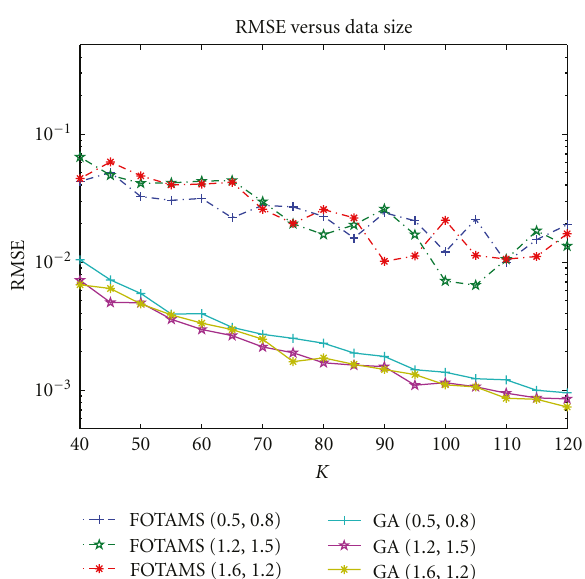
Figure 3: RMSEs of frequency estimation versus the data size, e ( m , n ) is white Gaussian noise, SNR = 0dB.